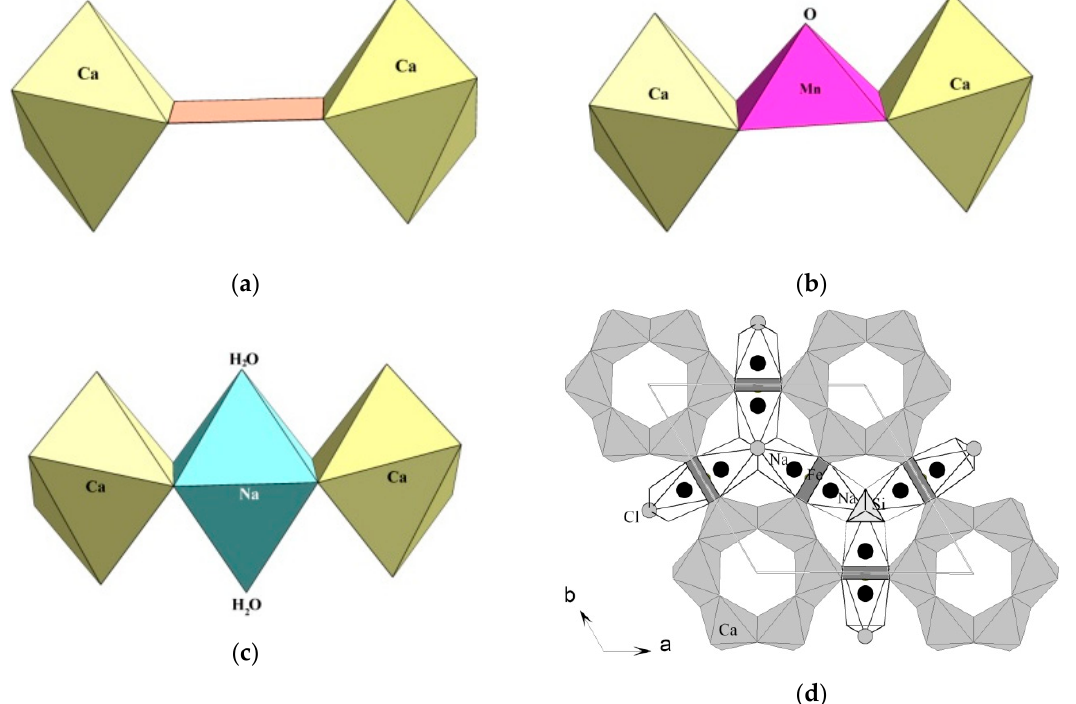
Table 1. Geometric parameters of the M 2O 4 polyhedra for different cations.